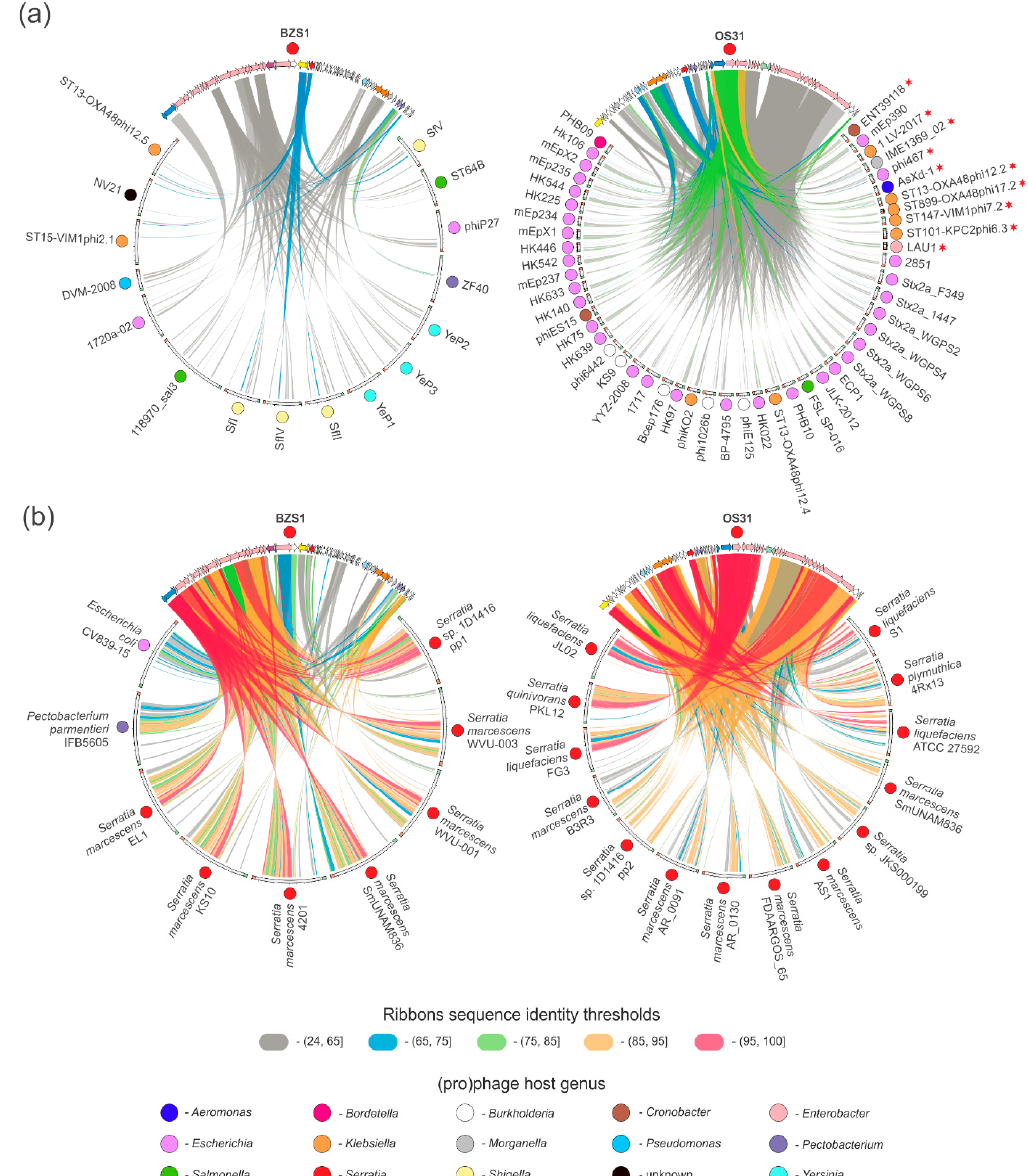
Figure 5. The comparison of BZS1 and OS31 phages with similar (pro)phages. The comparison was based on the comparison of BZS1 ‐ and OS31 ‐ encoded proteins against (a) proteins encoded by phages they were connected to in the network analysis and (b) prophages from bacterial genomes. The threshold of sequence identity shown with ribbons and (pro)phages’ hosts genus were labeled as shown on the legend. The anchors of ribbons correspond to protein ‐ encoding genes location. Green and orange rectangles at the ends of ideograms reflect the beginning and end of phage genome. Red stars were used to indicate phages that clustered with OS31 phage in vConTACT analysis.